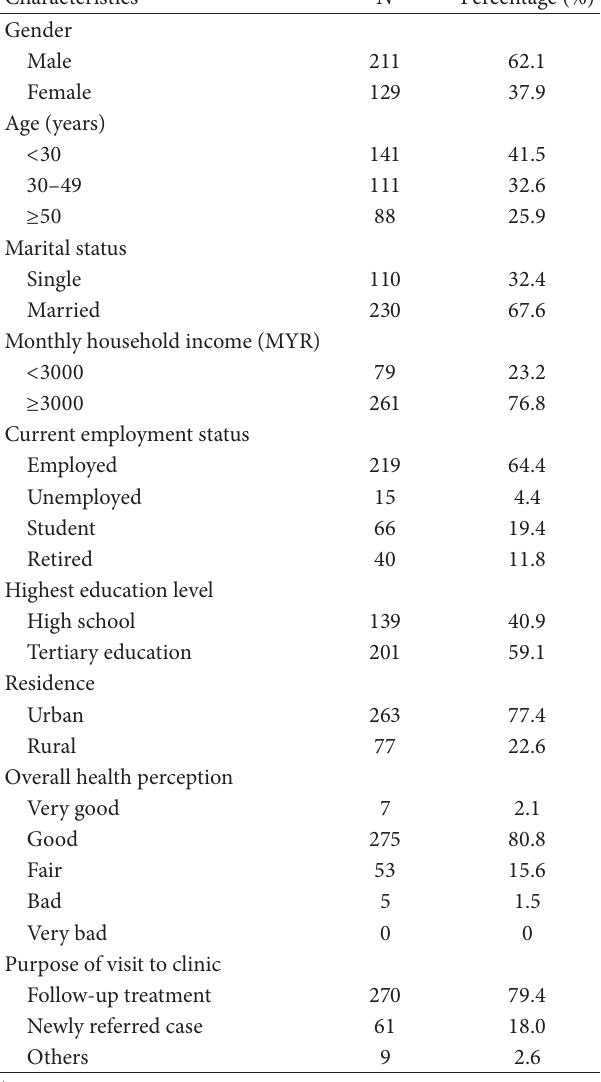
Table 1: Sample characteristics ( 𝑛 =